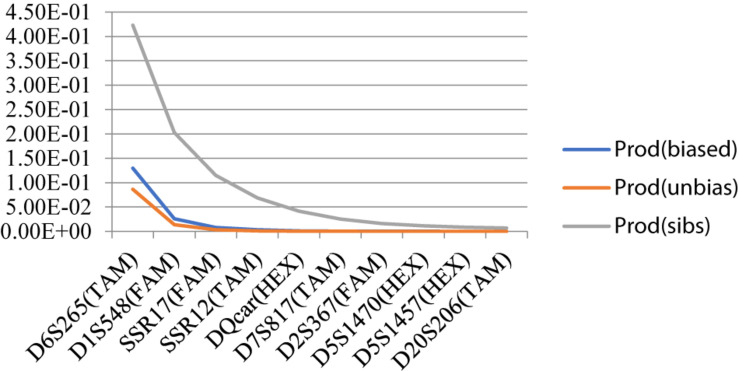
Individual identification system ability curve.